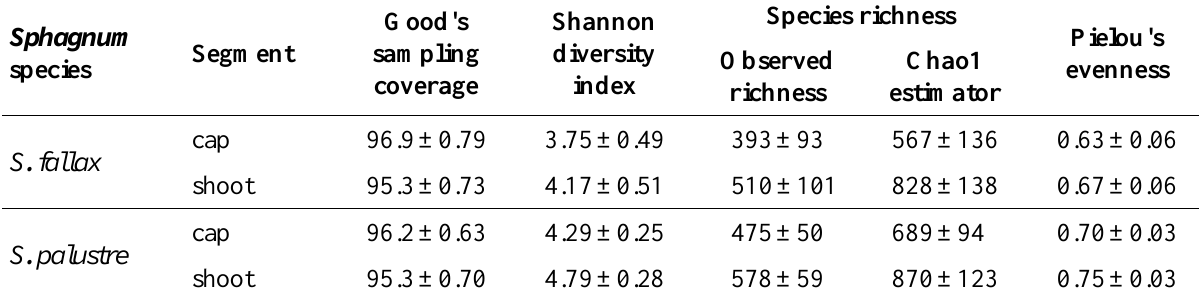
Table A4. Alpha diversity per Sphagnum species and segment (capitulum (cap) or stem).